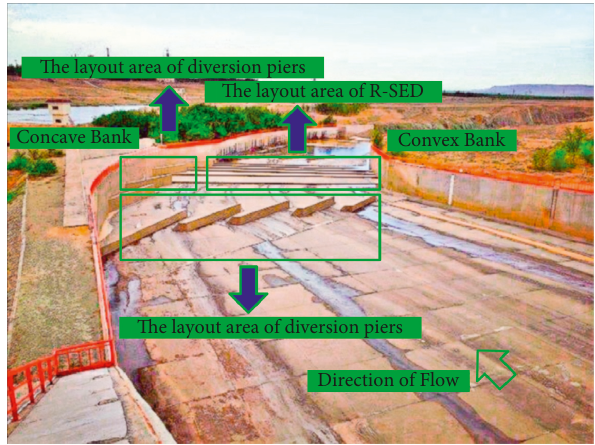
Figure 1: Joint energy dissipator of the rough-strips energy dis- sipator (R-SED) and the diversion piers in the curved section of the spillway of “635” reservoir in Xinjiang,